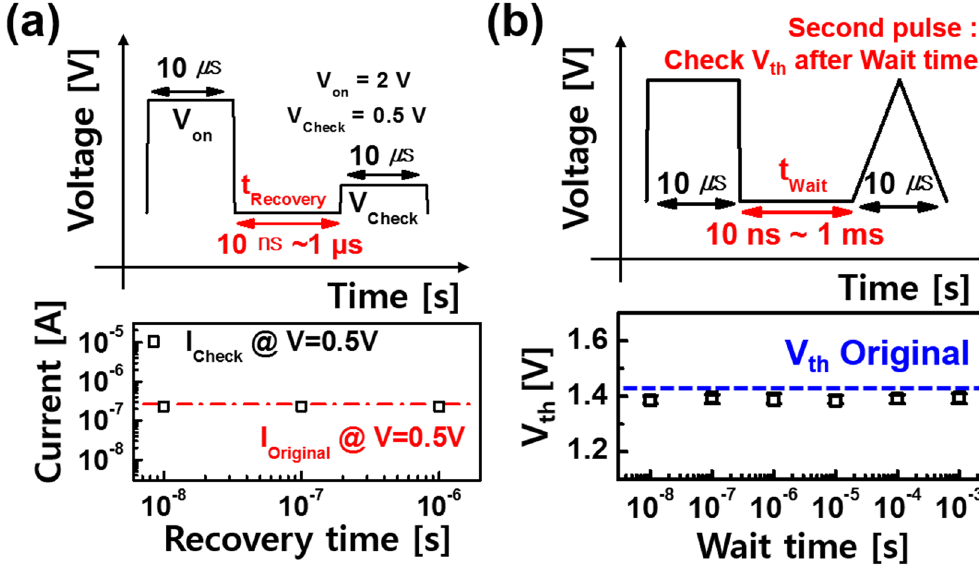
Figure 4. ( a ) NiO y /NbO x /NiO y device can recover its insulating state under 10 ns and ( b ) maintain its TS characteristics within different wait time (drift-free